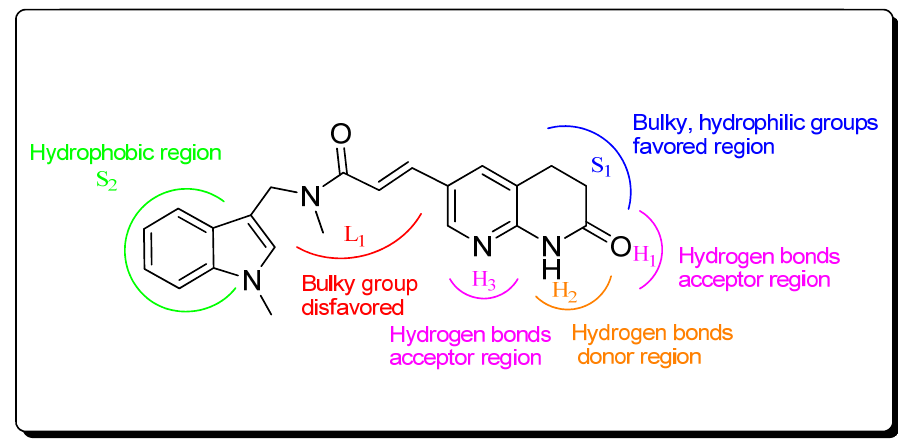
Figure 7. Structural requirements for formamides based FabI